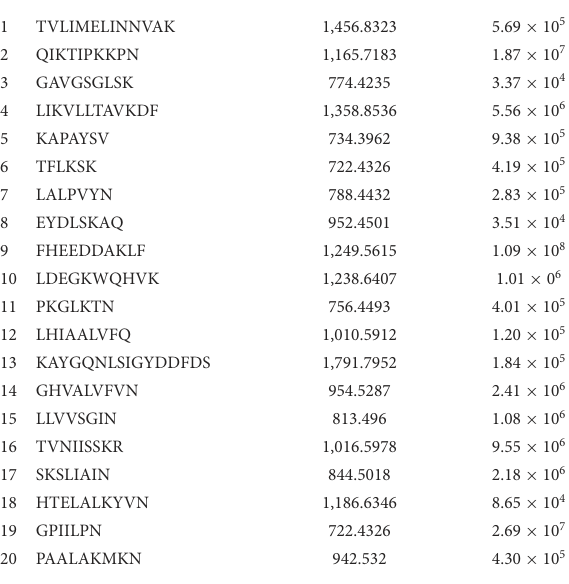
TABLE 2 Characteristics of peptides from MLPH1-1 and identified by LC-MS/MS. Amino acid sequence Molecular weight (Da) Peak